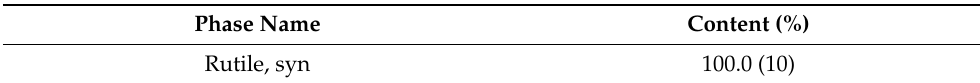
Table 2. Quantitative analysis of the results